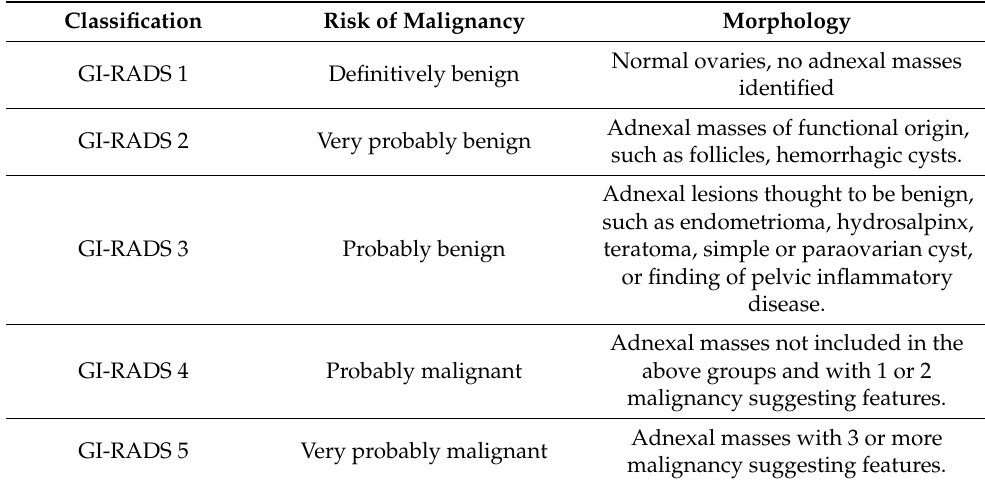
Table 1. The Gynecologic Imaging-Reporting and Data System (GI-RADS)